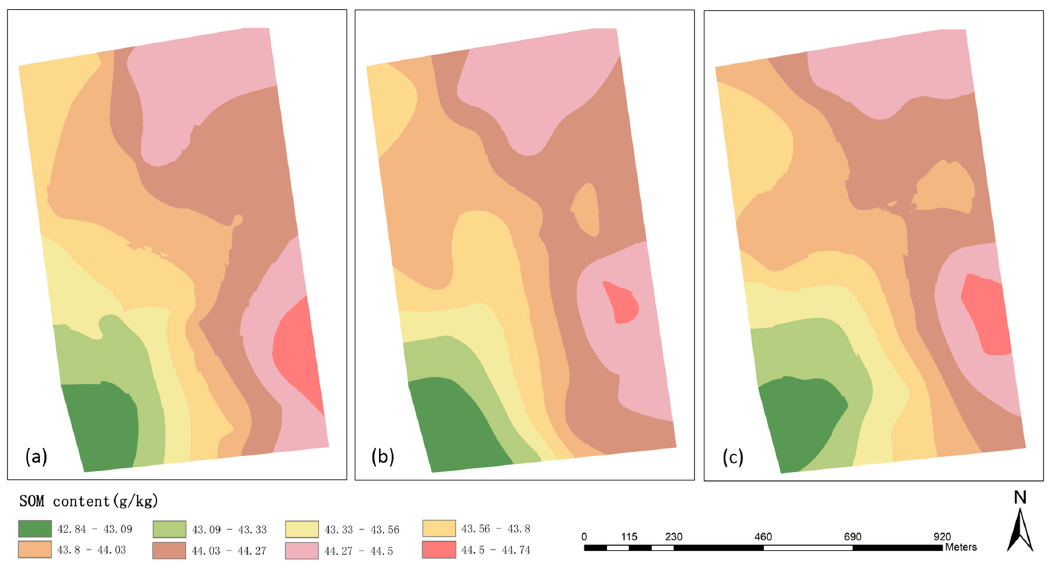
Figure 7. The predicted SOM content maps using the three groups of samples: ( a ) The proposed method with the optimal super-grid size, ( b ) regular grid sampling, and ( c ) k-means sampling.